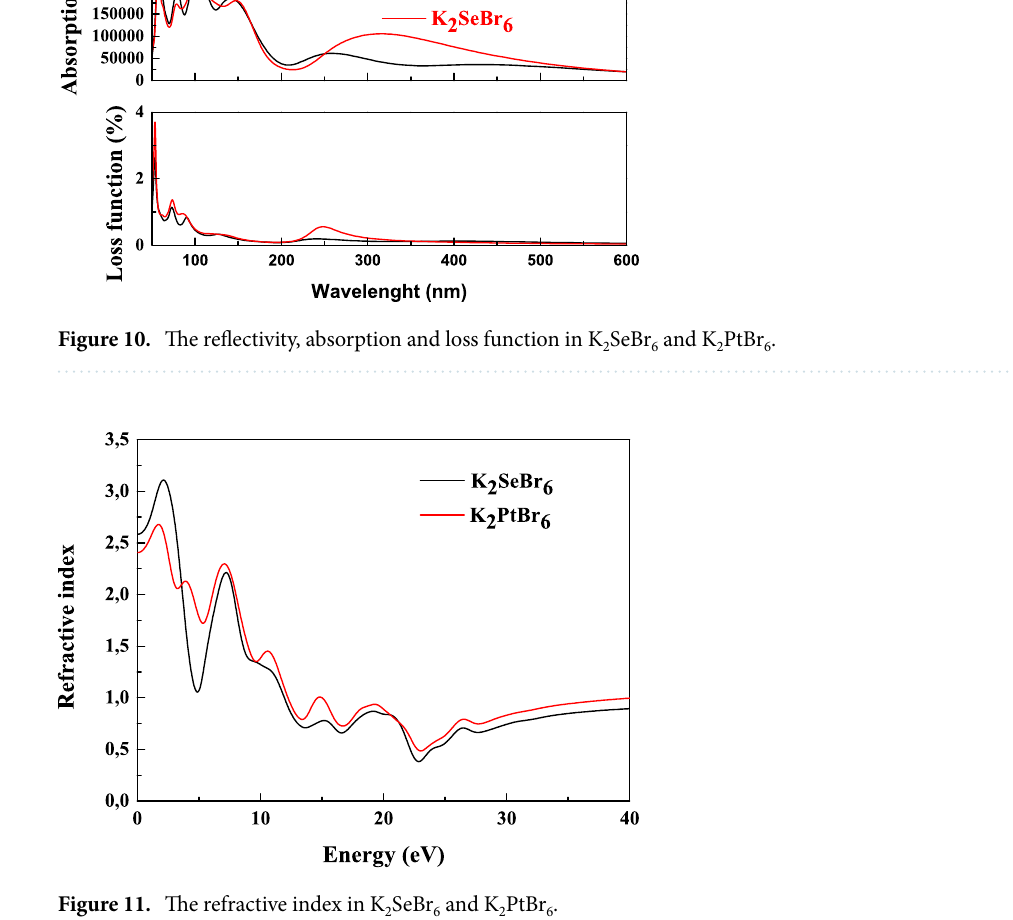
Figure 11. The refractive index in K 2 SeBr 6 and K 2 PtBr 6